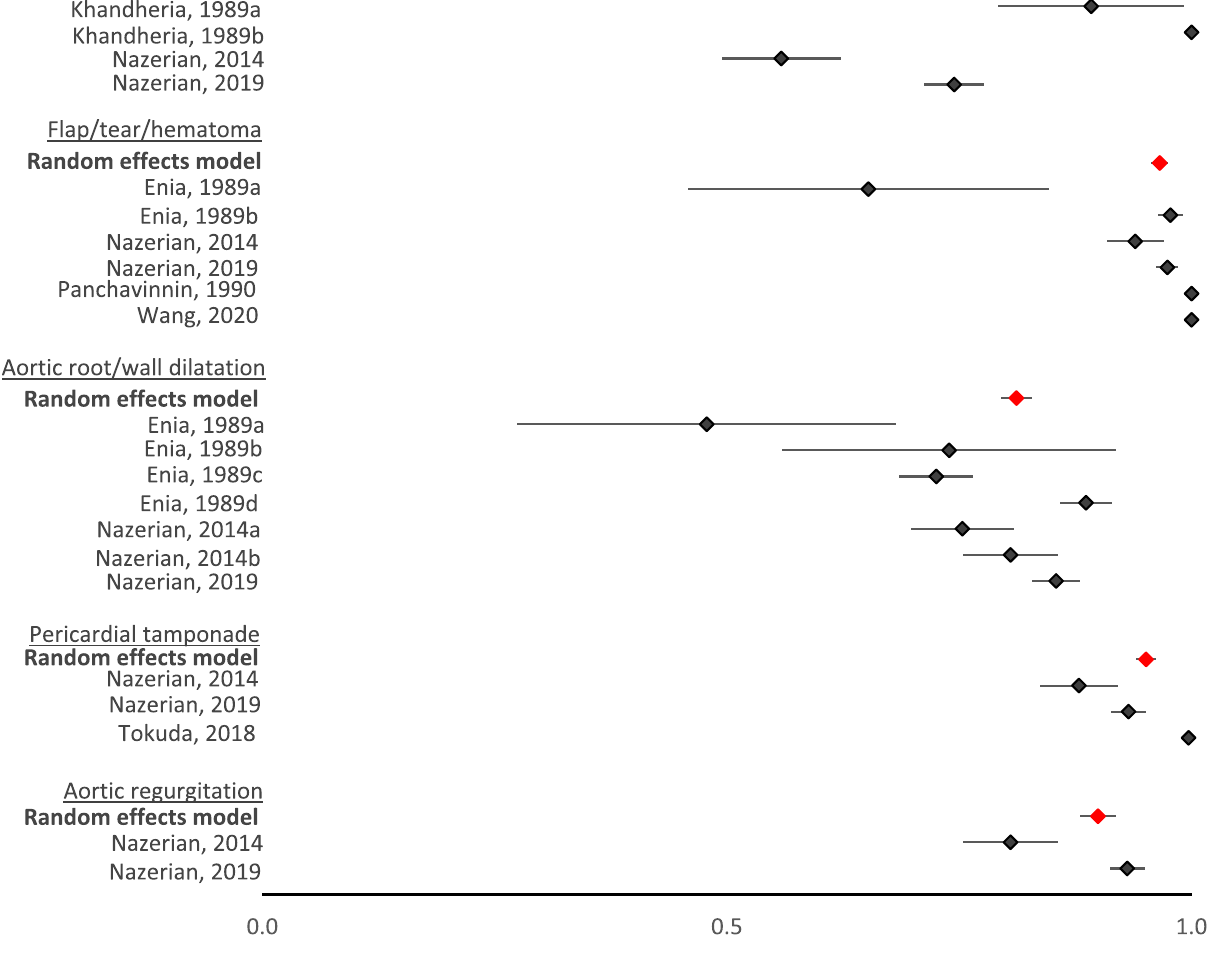
Figure 4. Forest plots of specificities of all studies. Lowercase letters denote subcategories of studies taking place within the article.